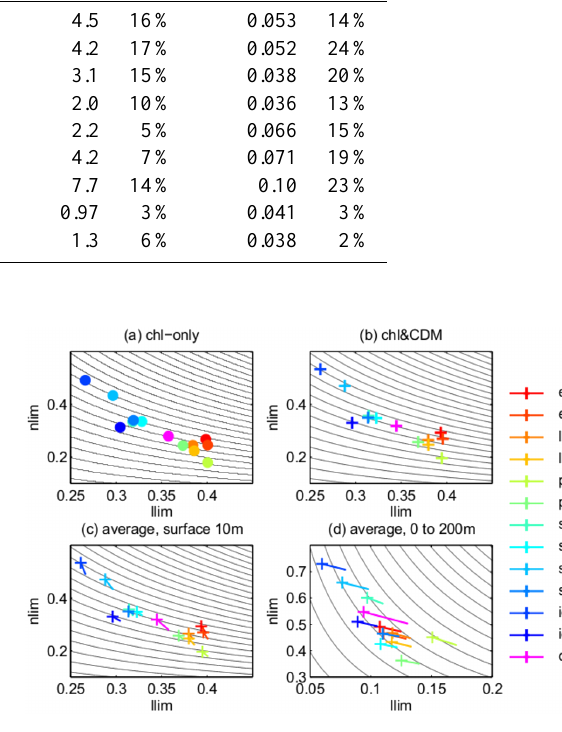
Figure 14. Light and nutrient limitation scaling factors for open ocean biomes and coastal regions. (a) Average nlim, llim for chl- only model run, from 0 to 10m (b) average nlim, llim for chl&CDM model run, from 0 to 10m (c) vectors connecting coordinates from panels (a, b) , average from 0 to 10m. (d) Vectors starting at coordi- nates from chl-only model run and terminating with an “ x ” at values from chl&CDM model run, average from 0 to 200m. Legend ab- breviations: ice is marginal ice zone, sp is subpolar, ss is seasonally stratified, ps is permanently stratified, ll is lower latitude, eq up is equatorial upwelling, eq down is equatorial downwelling, coastal is coastal regions, defined as the grid cells adjacent to land. Suffixes nh and sh stand for Northern Hemisphere and Southern